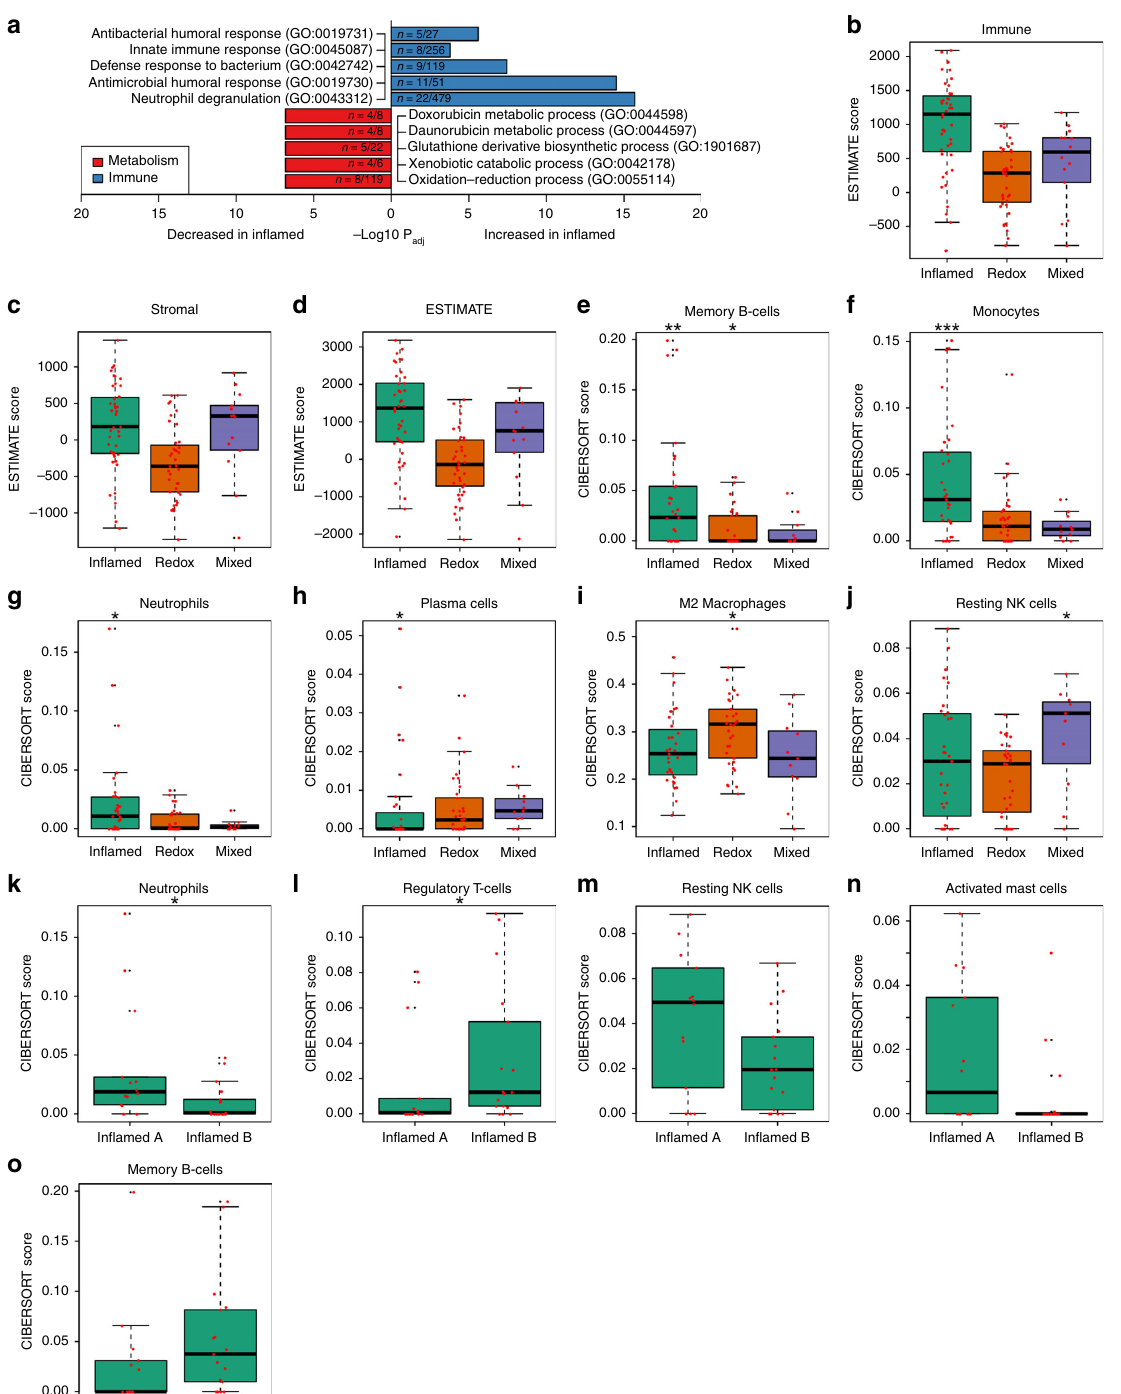
Fig. 2 The In fl amed subtype is immune rich. a Pathway enrichment of signi fi cantly different proteins (±1.5 fold-change and Wilcoxon P adj ≤ 0.05 compared to the rest of the cohort). The In fl amed subtype was enriched for immune pathways including neutrophil degranulation. b – d Immune, Stromal, and ESTIMATE scores from the ESTIMATE algorithm 18 . The In fl amed subtype had the highest median Immune score. e – o Box plots showing CIBERSORT results for each immune subtype compared across the three proteomic subtypes and between In fl amed A and In fl amed B 7 . In fl amed had signi fi cantly higher proportions of memory B-cells (Wilcoxon P = 5.73E-03), monocytes (Wilcoxon P = 3.78E-04), and neutrophils (Wilcoxon P = 0.021) compared to the other subtypes, and plasma cells were signi fi cantly lower (Wilcoxon P = 0.048). M2 macrophages were signi fi cantly higher in Redox (Wilcoxon P = 0.016), and resting NK cells were higher in Mixed (Wilcoxon P = 0.027). Regulatory T-cells were signi fi cantly higher in In fl amed B (Wilcoxon P = 0.039), and neutrophils were signi fi cantly higher in In fl amed A (Wilcoxon P = 0.025). box plots Signi fi cance was denoted using the following: * = P < 0.05, ** = P < 0.01, *** = P < 0.001. The center line indicates the median, the bounds of the box indicate the interquartile range (IQR: de fi ned as the difference between the 75th and 25th percentiles), the topmost and bottom-most horizontal lines indicate the most extreme points less than 1.5 times the IQR below the 25th or above the 75th percentile, black points indicate outliers, and red points indicate individual